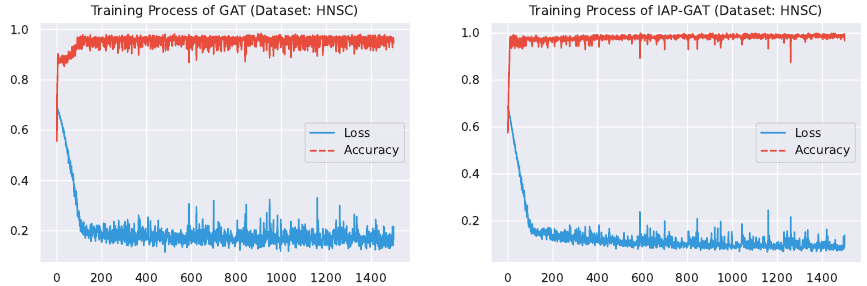
Figure A2. Training process of GAT and IAP-GAT on HNSC